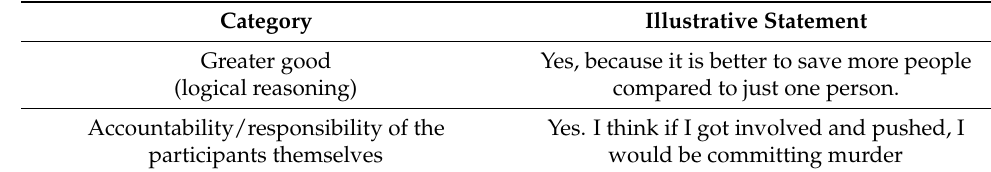
Table 1. Illustrative table for each statement in the content